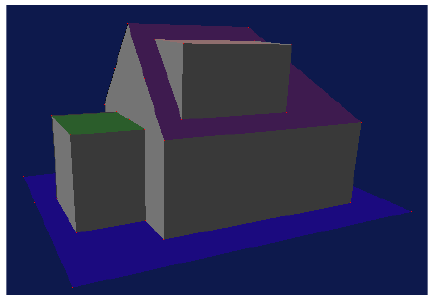
Fig. 1. Simple building as a TIN with vertical walls.